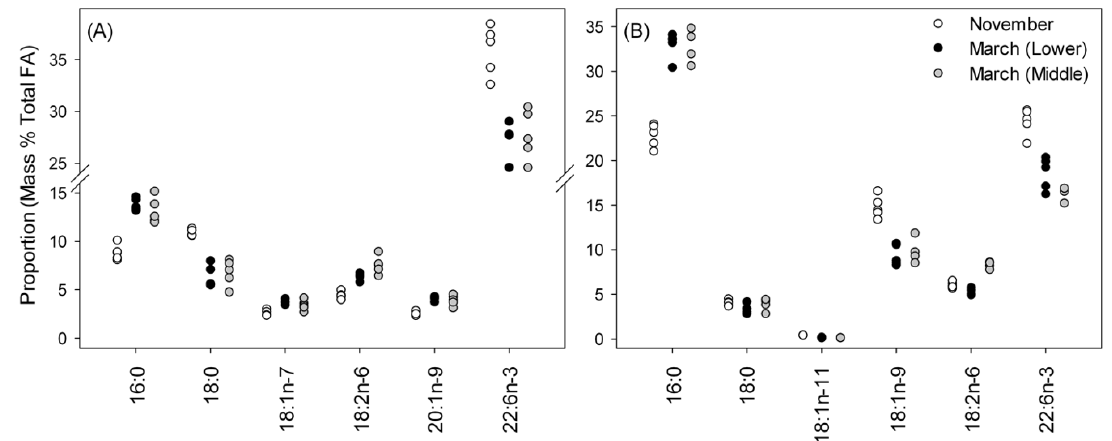
Figure 3. Proportions of fatty acids (FA) making greatest contributions to differences among samples in ( A ) phosphatidylethanolamine (PE; n = 5) and ( B ) phosphatidylcholine (PC; n = 5) in muscle. For all FA in PE, November samples are different (Tukey’s test; p < 0.05) from both March samples. For PC, November samples are different from both March samples for all FA, except 18:0, where samples were equivalent.